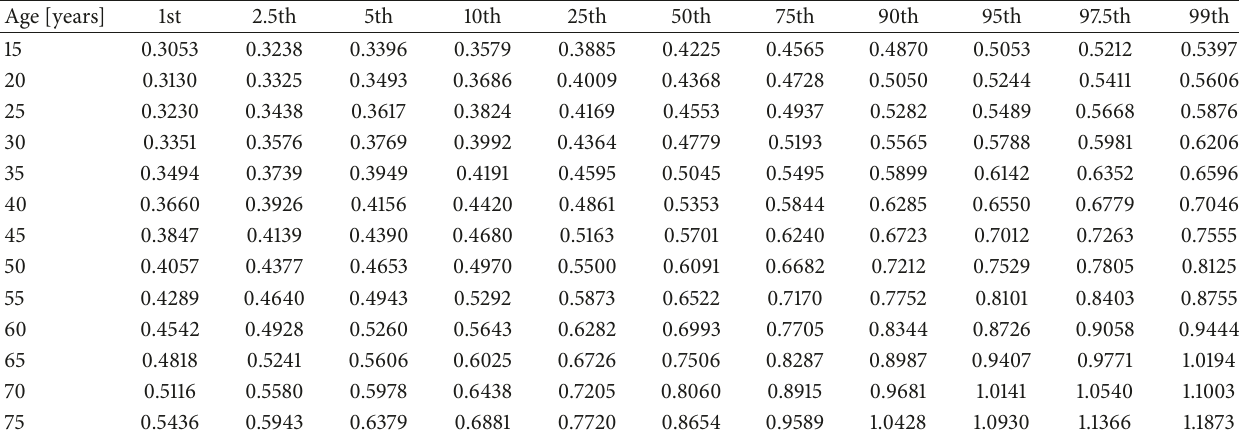
Table 6: Common carotid intima media thickness [ mm ] percentiles for healthy female subjects (average of right and left arterial